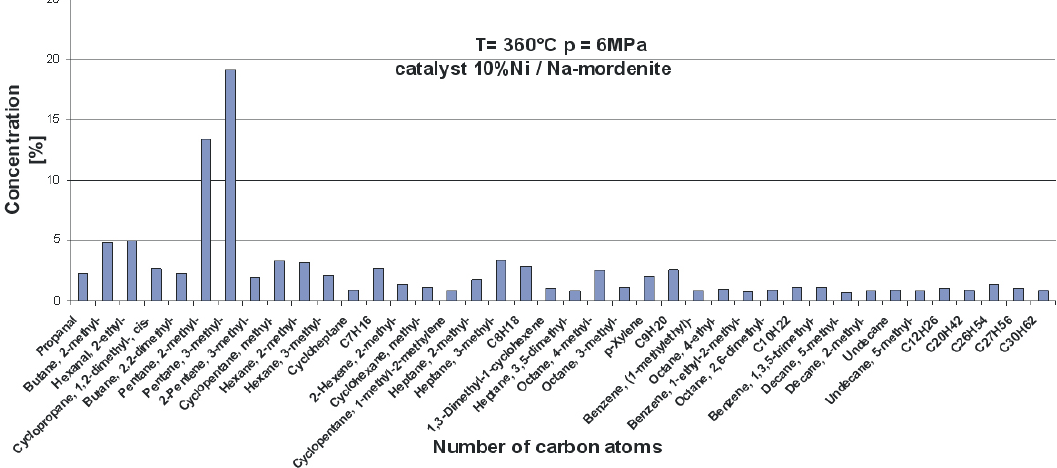
Figure 7. Hydroconversion of LTP56-H paraffin conducted for 4 h at 360°C over 10%Ni/Namordenite and in the pressure range 60-380 bar (paraffin dissolved with hexane, catalyst after reduction at 400°C in pure hydrogen for 2